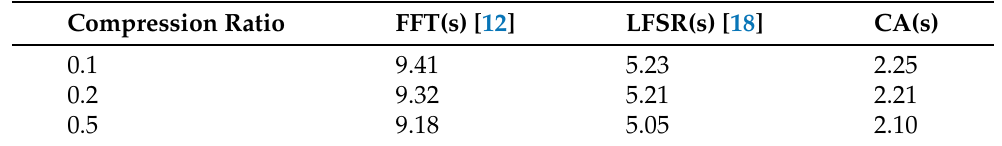
Table 3. Effect of compression rate on algorithm running